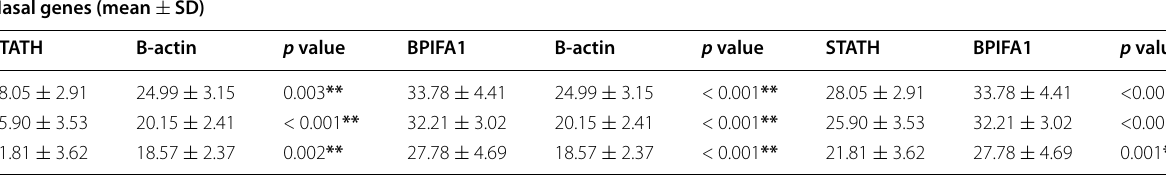
B-actin Beta-actin, STATH Statherin, BPIFA1 Lipid-binding protein that plays a role in the innate immune responses of the upper airway, SD Standard